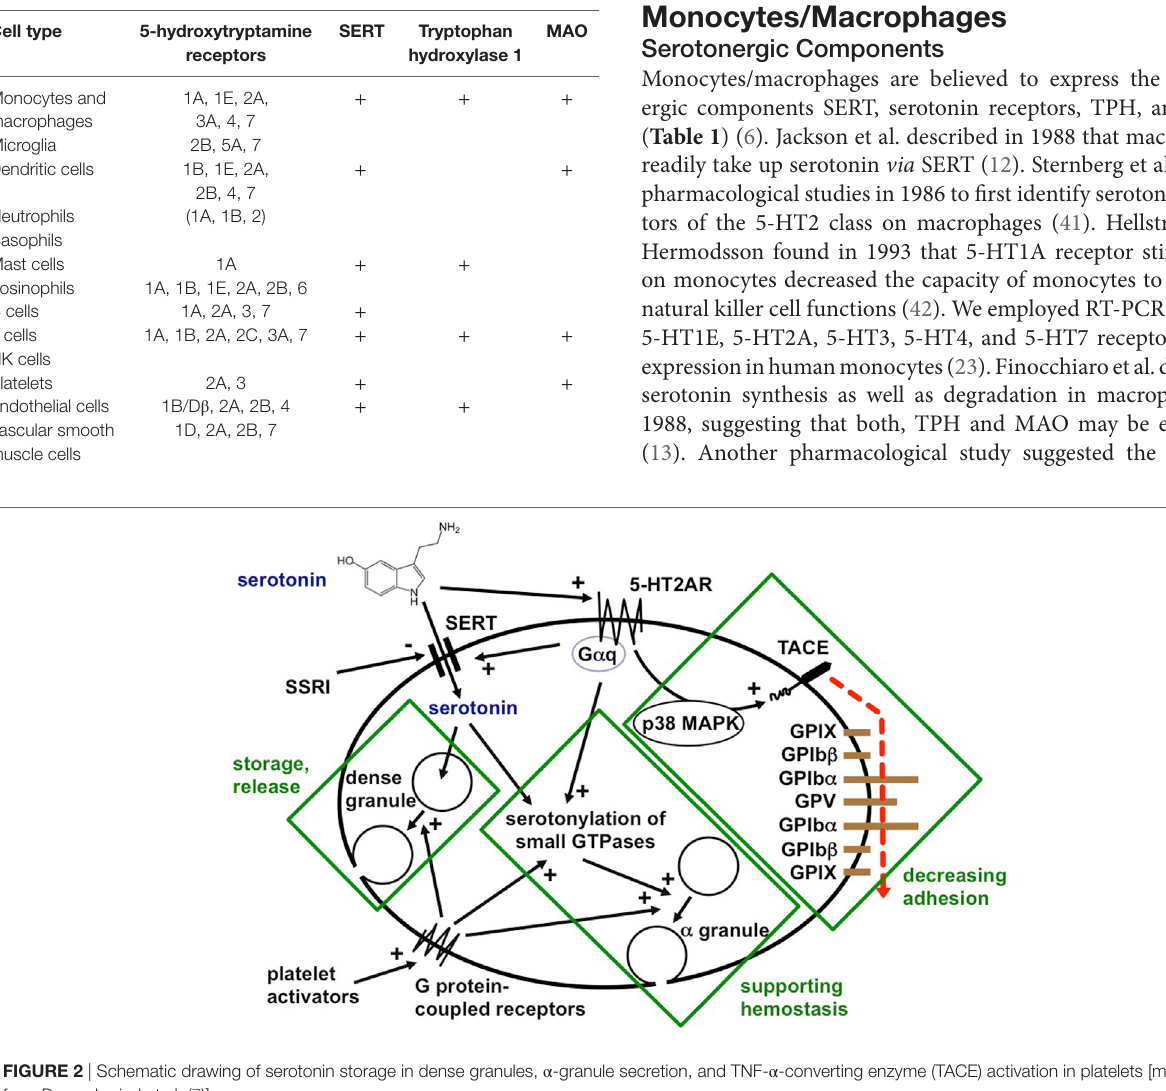
TabLe 1 | Serotonergic components of immune cells.